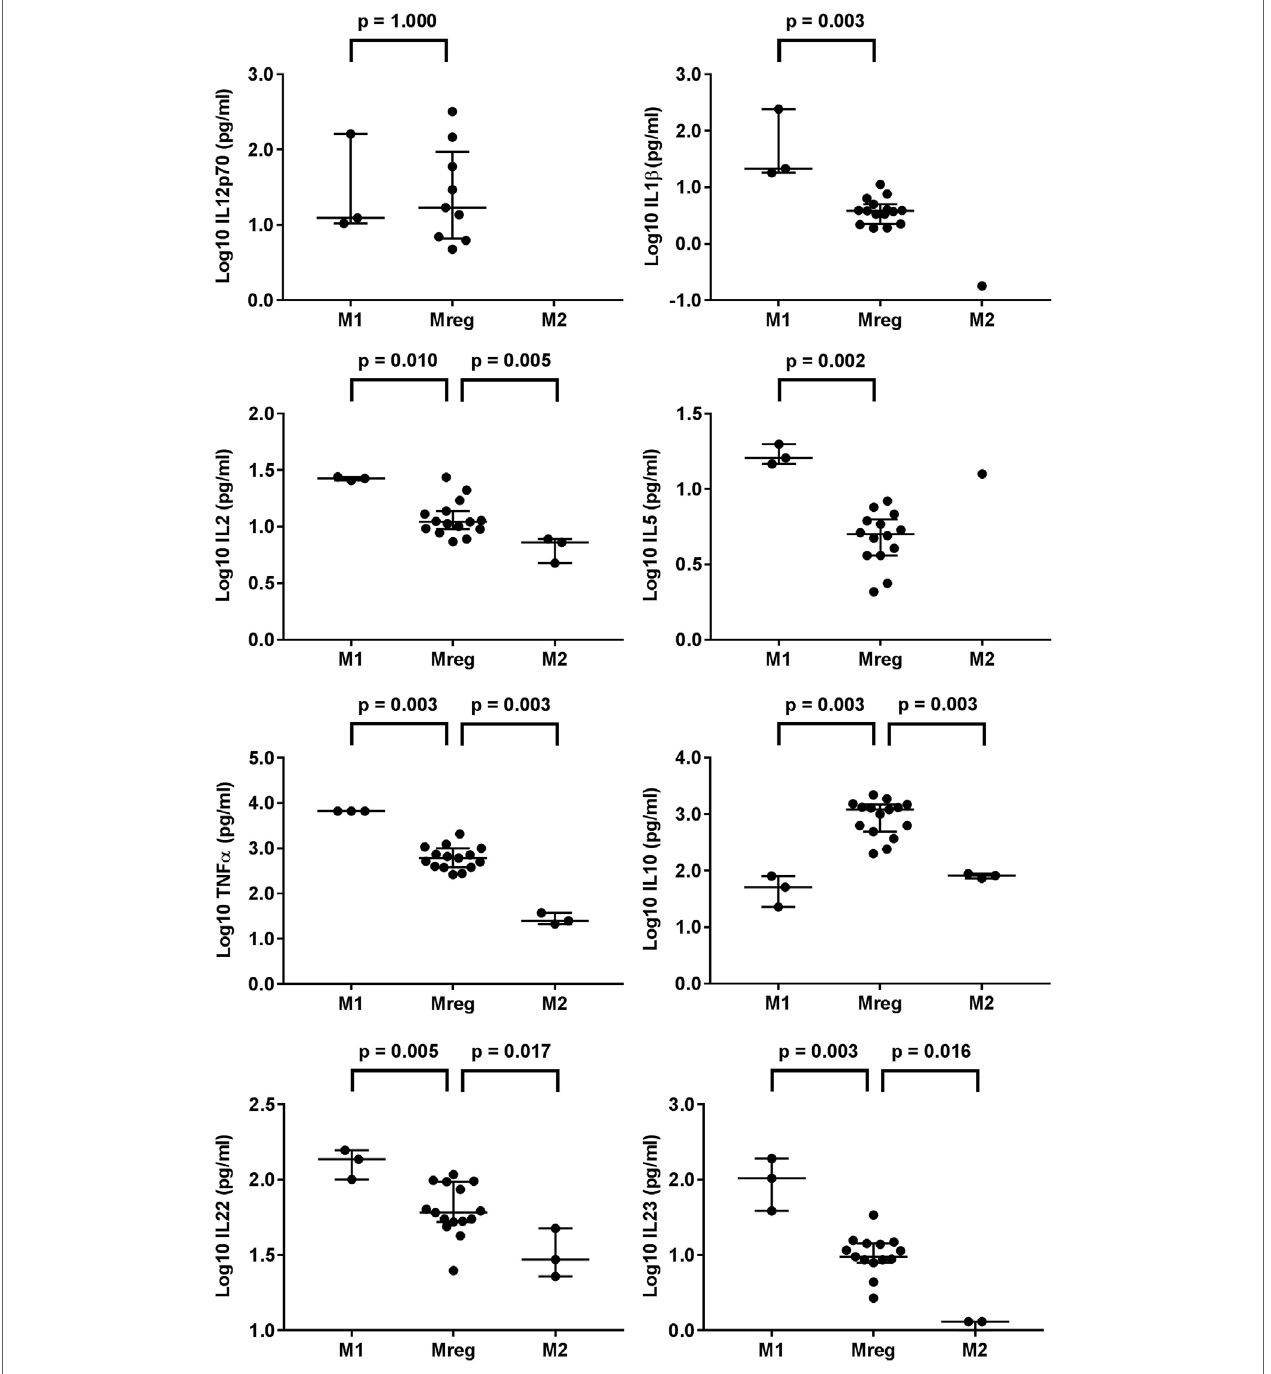
FigUre 2 | Level of cytokines in Mreg-, M1-, and M2-conditioned media. The media were analyzed for 18 cytokines, and measures within the cytokine-specific detection range were included in the analysis. The values of cell culture media cytokines were log10-transformed. The significance in pairwise variation between M1 and Mreg, and M2 and Mreg was analyzed using the Mann–Whitney U test, and the results are expressed as median with interquartile range. The number of biological replicates varies from 3 (for M1 and M2) to 15 for Mreg. Abbreviations: IL, interleukin; M1, classically activated “host defense” macrophage; M2, alternatively activated “wound-healing” macrophage; Mreg, regulatory